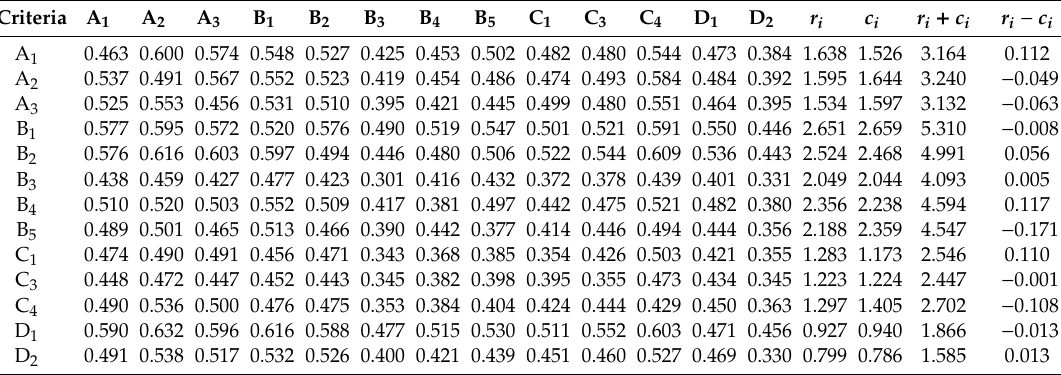
Table 7. Total relation matrix ( T D ) and derived prominence and relation of selection criteria. Criteria A